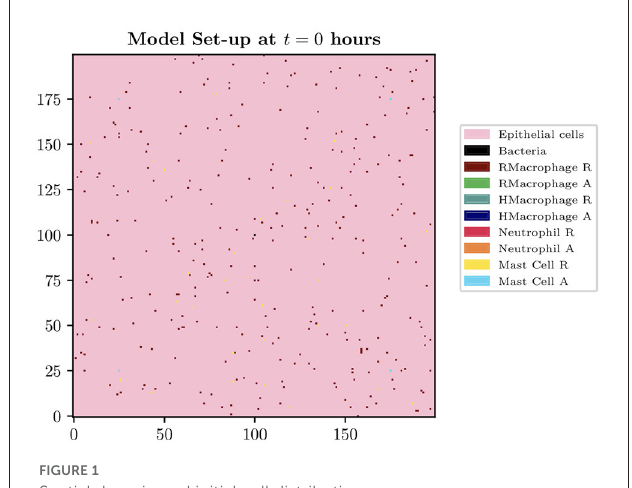
FIGURE1 Spatial domain and initial cell